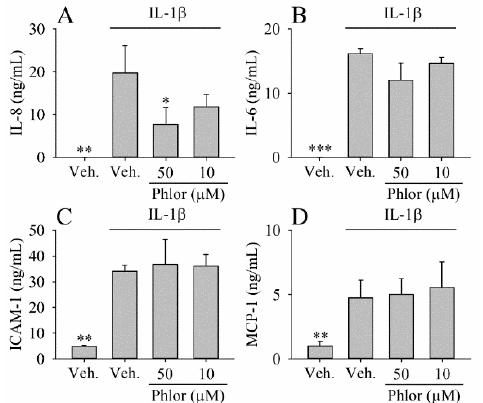
Figure 3. Level of cytokines and adhesion proteins analyzed in culture medium and protein extract, respectively, by enzyme-linked immunosorbent assay (ELISA). The myofibroblasts of colon were treated with IL-1 β (1 ng/mL) alone or in combination with Phlor (50 and 10 μ M) for 24 h and the level of IL-8 ( A ), IL-6 ( B ), ICAM-1 ( C ), and MCP-1 ( D ) determined. Statistically significant differences are shown as follows: * p < 0.05, ** p < 0.05, *** p < 0.001.